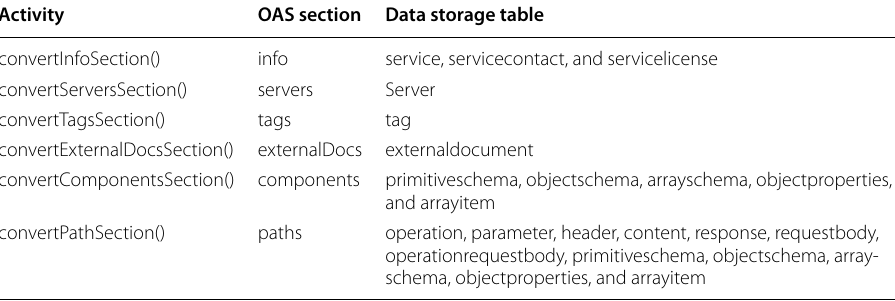
Table 3 Extraction mapping on OAS document and database schema Activity